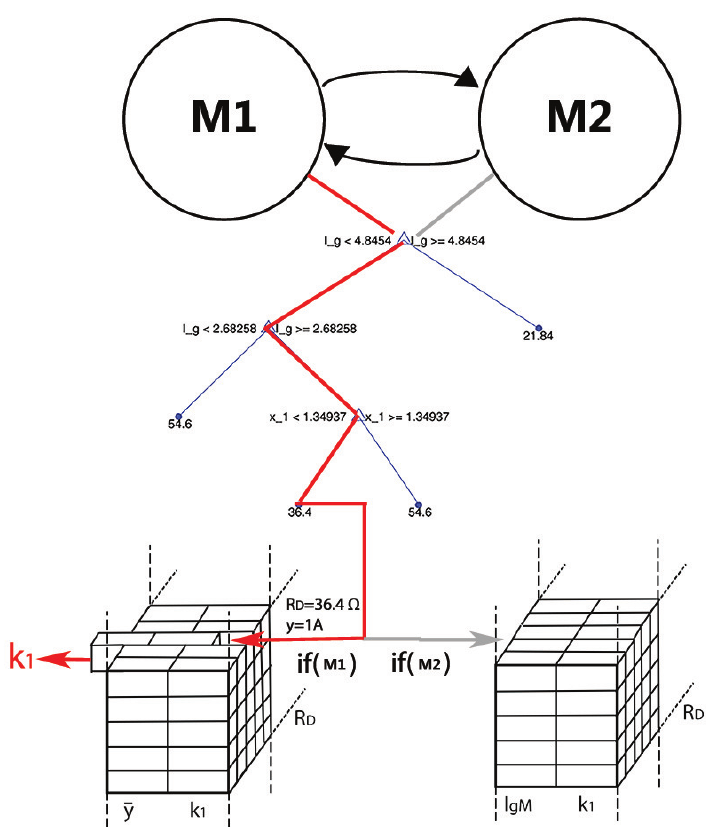
Figure 8. An example of the gain k 1 computation. Starting from Mode M1, a generator current I g = 3 A and inductor current x 1 = 1 A are measured. The red path is activated on the tree, producing the estimate R D = 36.4 Ω . Finally, a table lookup is performed to compute k 1 .